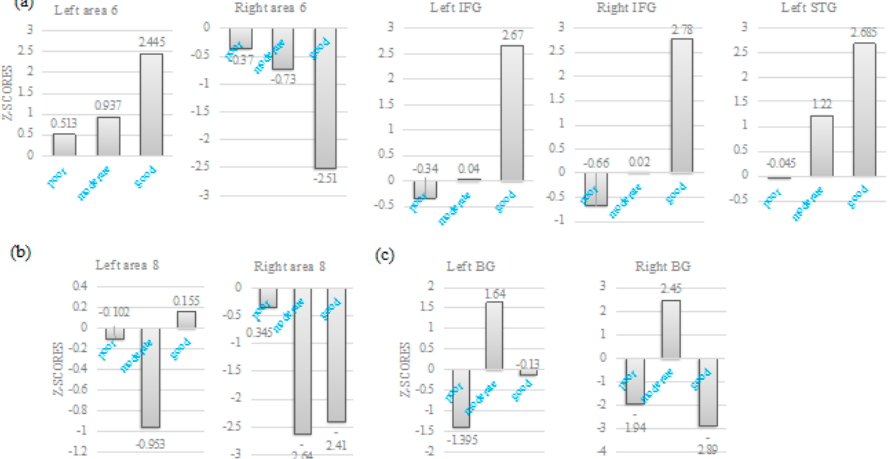
Figure 6. Intergroup comparison of Z-scores. ( a ) Higher Z-scores at left area 6, bilateral IFG and left superior temporal gyrus (STG) were observed with better word retrieval, while lower Z scores at right area 6 showed with better word retrieval. ( b , c ) Z-scores at bilateral area 8 ( b ) and bilateral basal ganglia ( c ) were seemingly independent of word retrieval